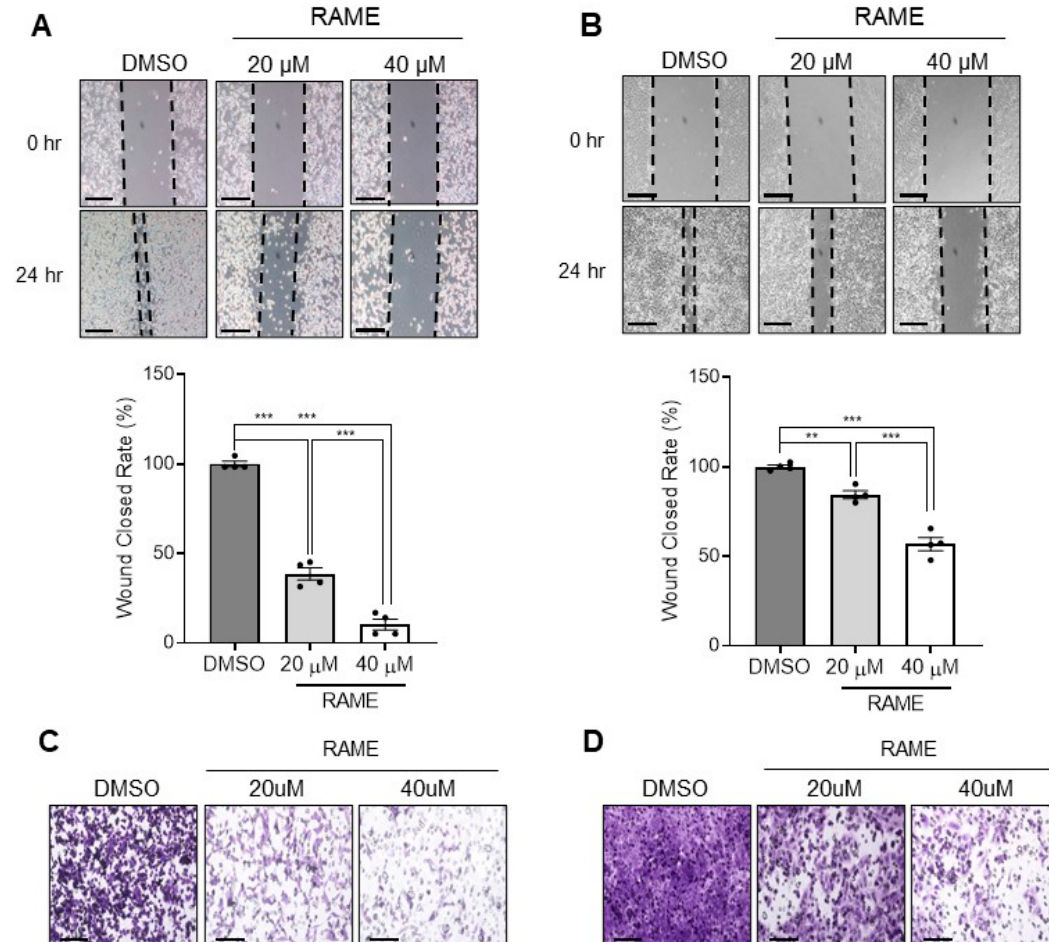
Figure 3. RAME inhibits cell migration and invasion in an ovarian cancer cell line. ( A ) Gaps of SKOV-3 after 24 h of RAME treatment at concentrations of 0, 20, and 40 µM (upper) and its quantitative wound close rate (lower). Scale bar = 200 µm. ( B ) Gaps of TOV-21G after 24 h of RAME treatment at concentrations of 0, 20, and 40 µM (upper) and its quantitative wound close rate (lower). Scale bar = 200 µm. ( C ) Invaded cells after RAME treatment for 24 h at concentrations of 0, 20, and 40 µM in SKOV-3 cells. Scale bar = 100 µm. ( D ) Invaded cells after RAME treatment for 24 h at concentrations of 0, 20, and 40 µM in TOV-21G cells. Scale bar = 100 µm. Error bars represent the mean ± SEM ( n = 3). * p < 0.05, ** p < 0.01, *** p < 0.001; unpaired t -test.